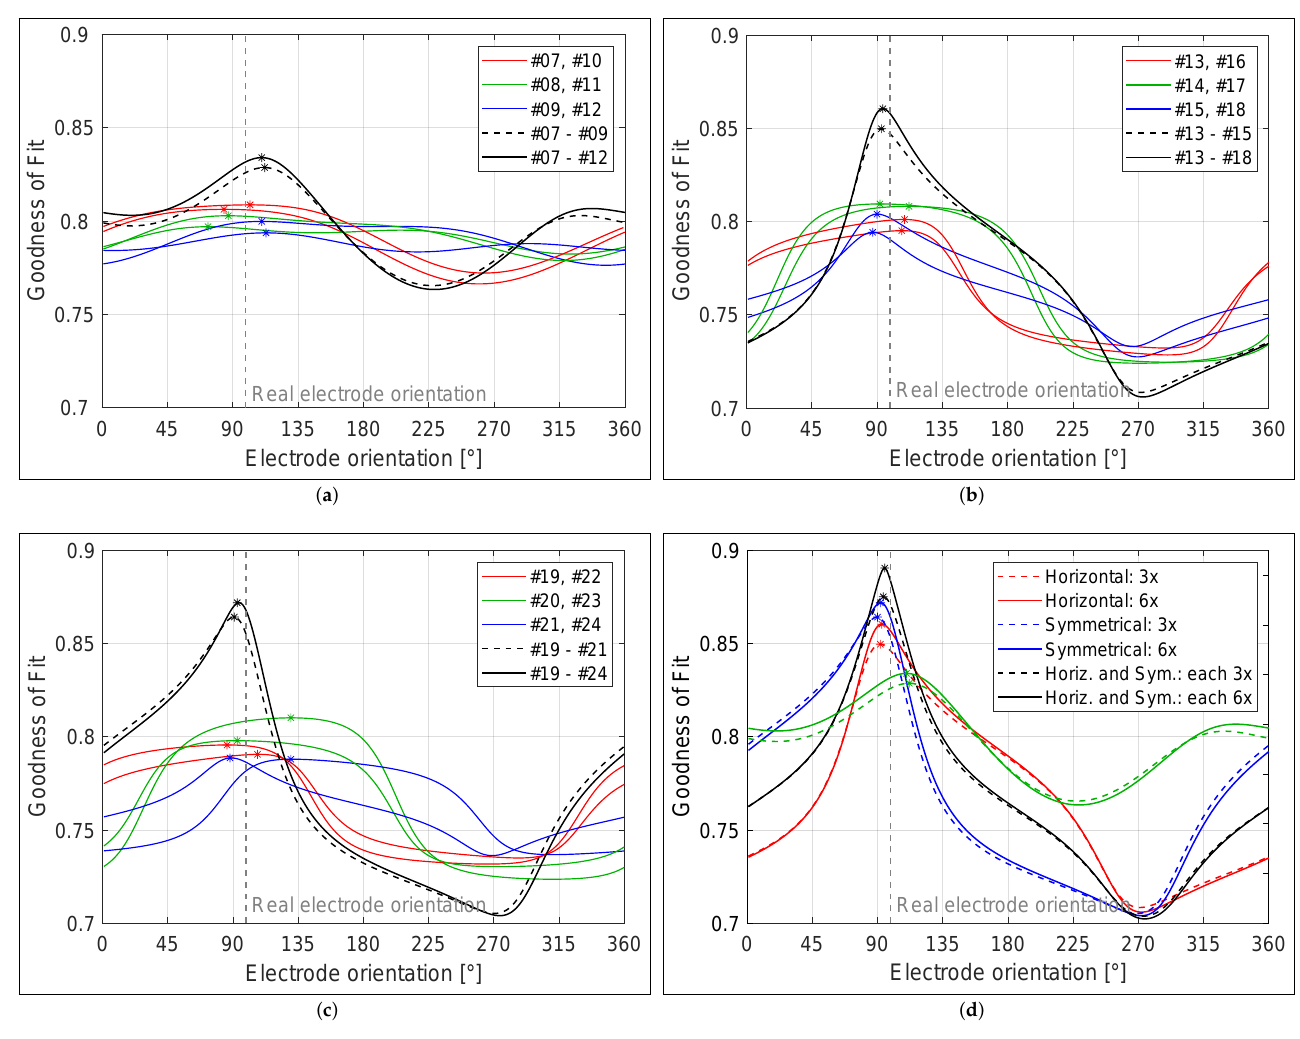
Figure 12. Results of electrode orientation detection for measurements with ( a ) diagonal, ( b ) horizon- tal, and ( c ) symmetrical electrode configurations. ( d ) Results for measurements with both horizontal and symmetrical electrode